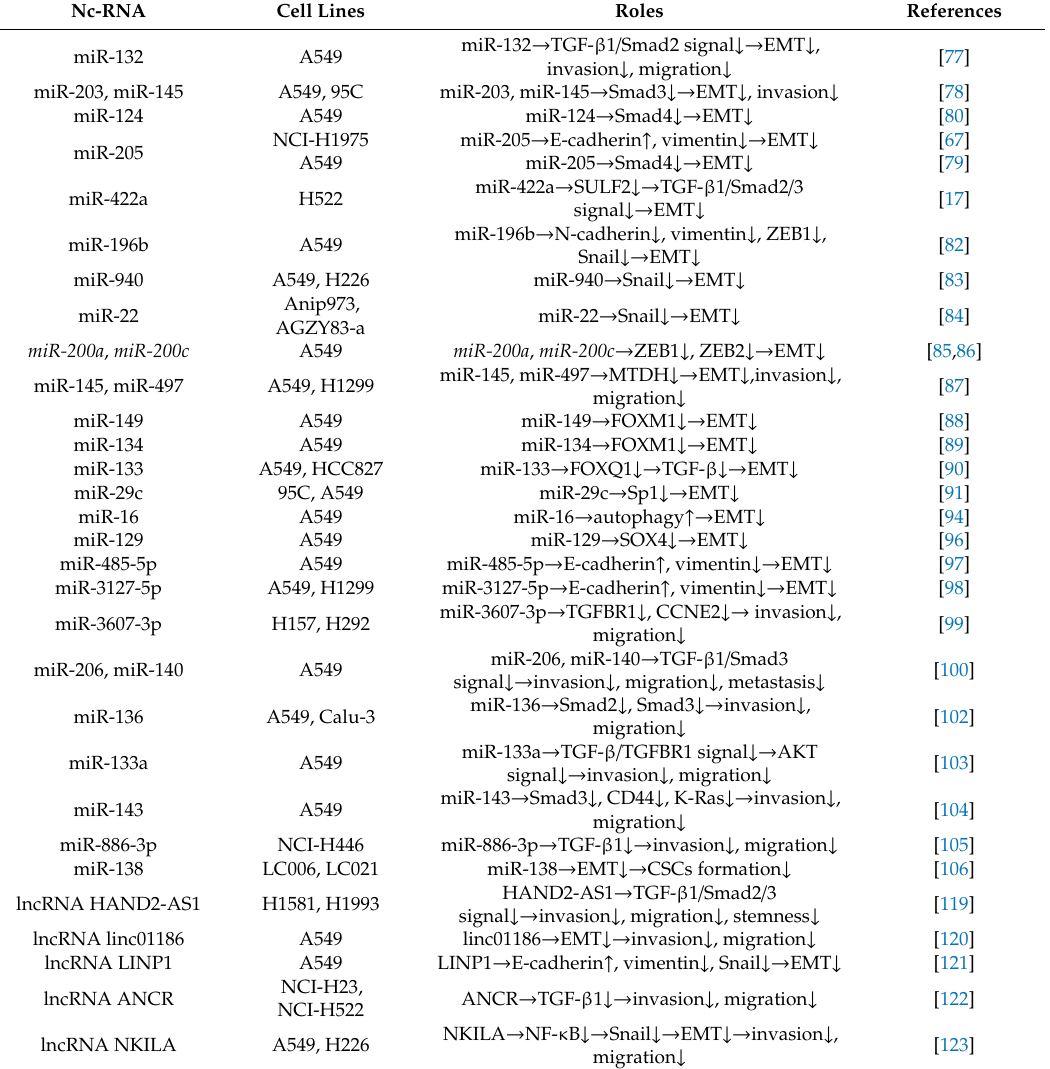
Table 2. The negative roles of miRNAs and lncRNAs in TGF- β signaling-regulated lung cancer